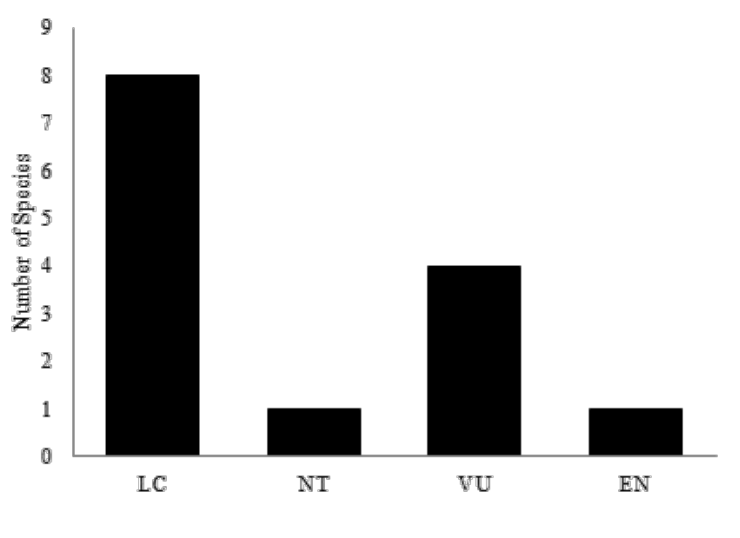
Figure 4: Categorization of species based on assigned National Conservation Statuses (LC = Least Concerned; NT = Near Threatened; VU= Vulnerable and EN=